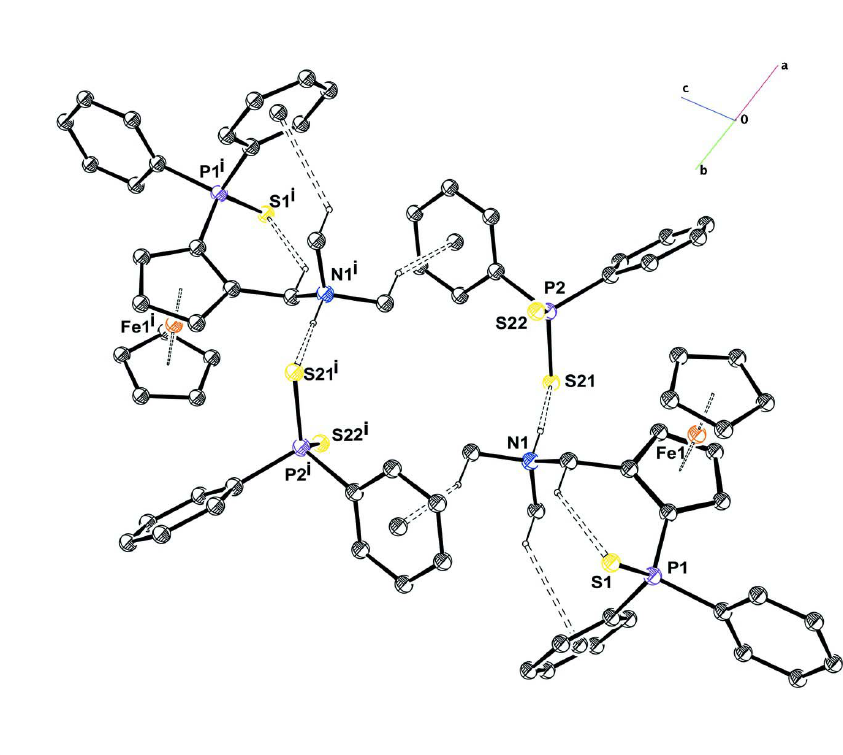
Figure 2 View showing the formation of pseudo dimer resulting from C—H··· π interaction. H atoms are represented as small sphere of arbitrary radii and the H bonds are shown as dashed lines. H atoms not involved in hydrogen bonding have been omitted for clarity. [ Cg 1 and Cg 2 are respectively the centroids of the C111 to C116 and C221 to C226 phenyl